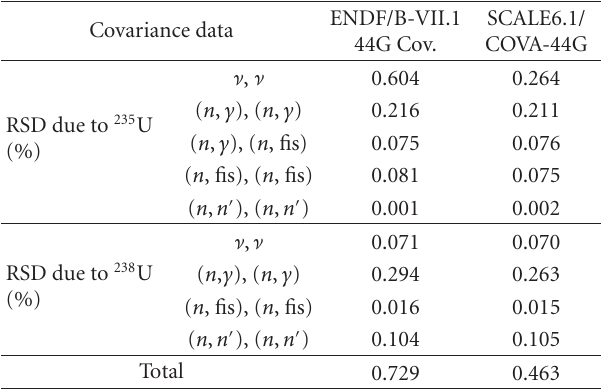
Table 1: Comparison of k uncertainties due to the covariance of 235 U and 238 U from ENDF/B-VII.1 and SCALE6.1/COVA. Covariance data